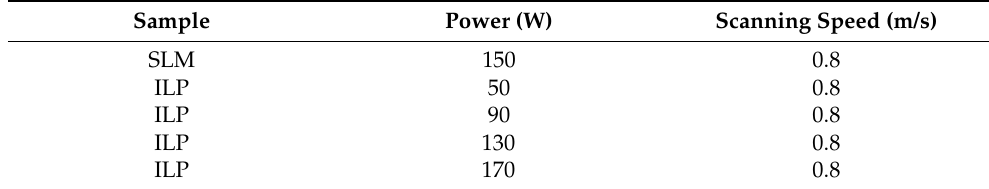
Table 2. Process parameters used in the modelling computation of SLM followed by ILP with different power. Table 2. The process parameters used to fabricate the as-SLMed and ILPed samples in the simula- tion.